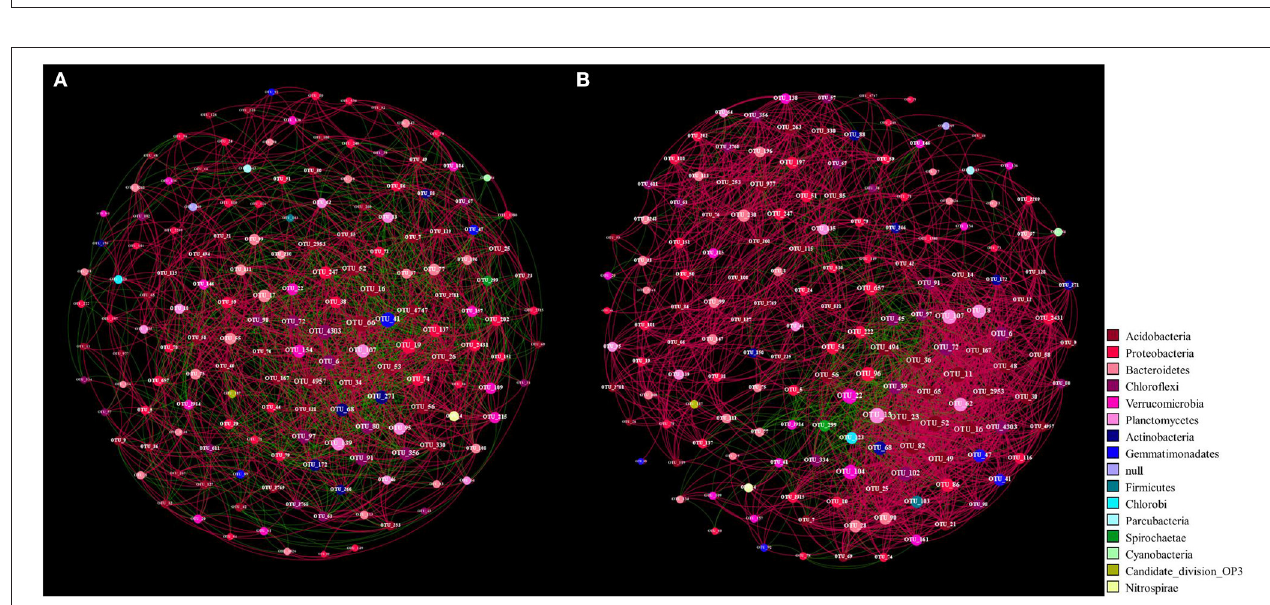
FIGURE 5 | the position along the y-axis represents the abundance fold-change compared with Si0 (A) . UpSet plot showing the number of OTUs that are unique or shared between the three sugarcane varieties under three two silicon (Si) treatments (B) . Blue column, the common OTUs for each treatment; red column, the common OTUs for Si200 treatments; light blue, green, orange column, the unique OTUs for ASi200, BSi200, CSi200, respectively (B) . Canonical correspondence analysis (CCA) based on the bacterial community compositions of three sugarcane varieties samples (C) under the two Si treatments. *,Significant at the 0.05 probability level.